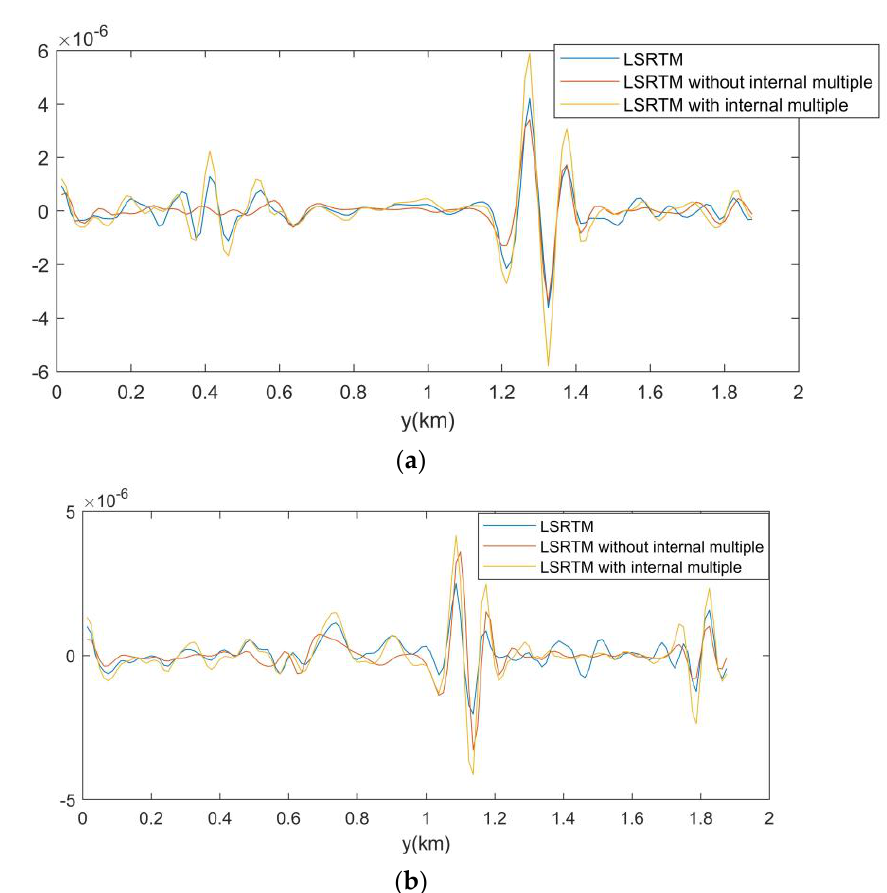
Figure 9. ( a ) the comparison of the 290th trace. ( b ) the comparison of the 320th trace.